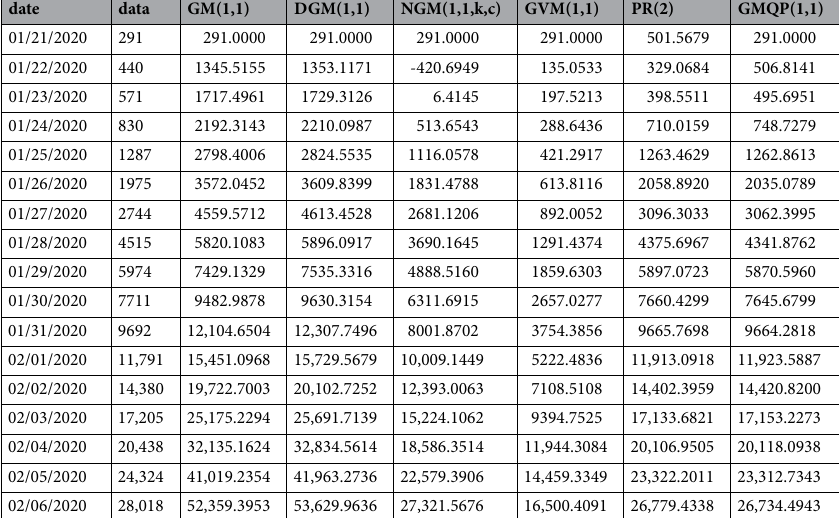
Table 9. The computational results of the confirmed cases of COVID-19 of China.